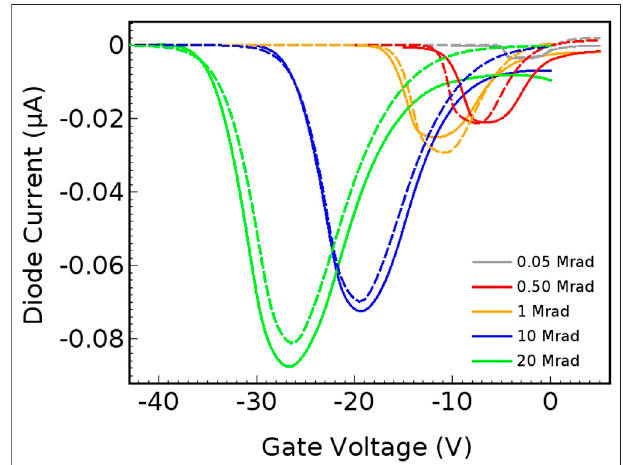
FIGURE 10 | C-V characteristics of FBK n-type MOS capacitors irradiated withXraydosesof0.05, 0.10,0.50, 10,20 Mrad(SiO 2 ):comparison between measurements (solid lines) and simulations (dashed lines).